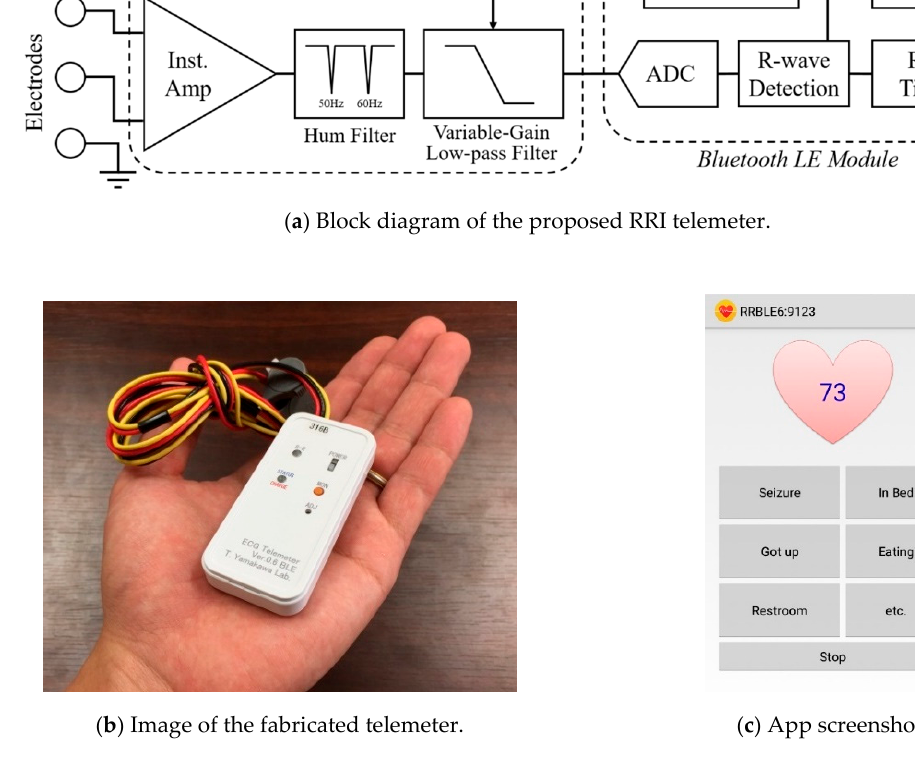
Figure 2. ( a ) Block diagram and ( b ) image of the proposed RRI telemeter. ( c ) Screenshot of the developed Android app showing memo buttons; current heart rate appears on the heart while monitoring. Instrumentation amplifier (Inst. Amp), analog-to-digital converter (ADC), receiver and transmitter (Rx/Tx).